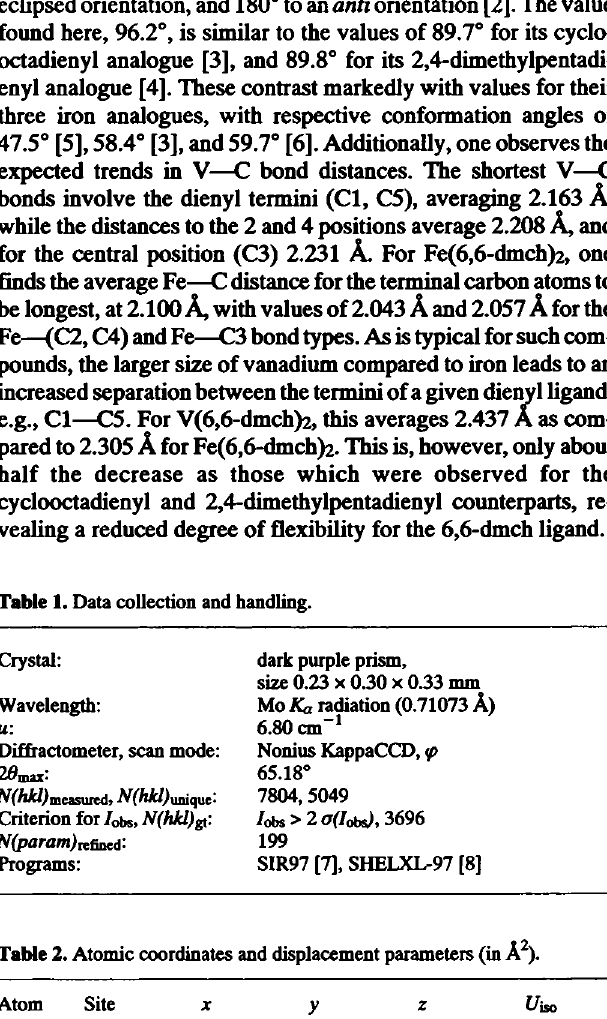
Table 2. Atomic coordinates and displacement parameters (in A 2